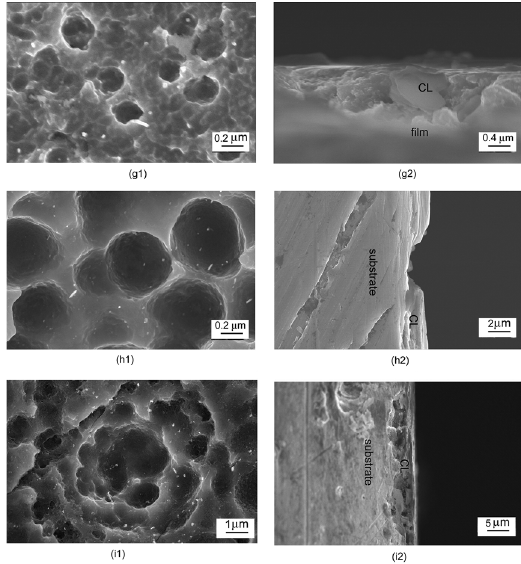
Figure 6. The surface and section morphology images of Al film samples observed by SEM after corrosion experiment in SBF (d, e and f are corresponding to 3 days, 10 days and 15 days corrosion, respectively. The left column of the figure is corresponding to surface morphology and the right column corresponding to section morphology).